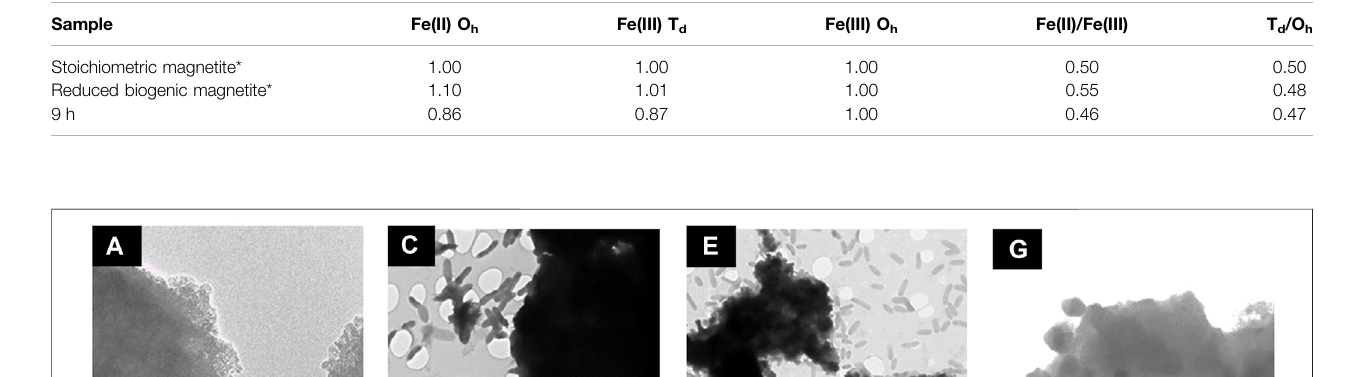
Frontiers in Earth Science |